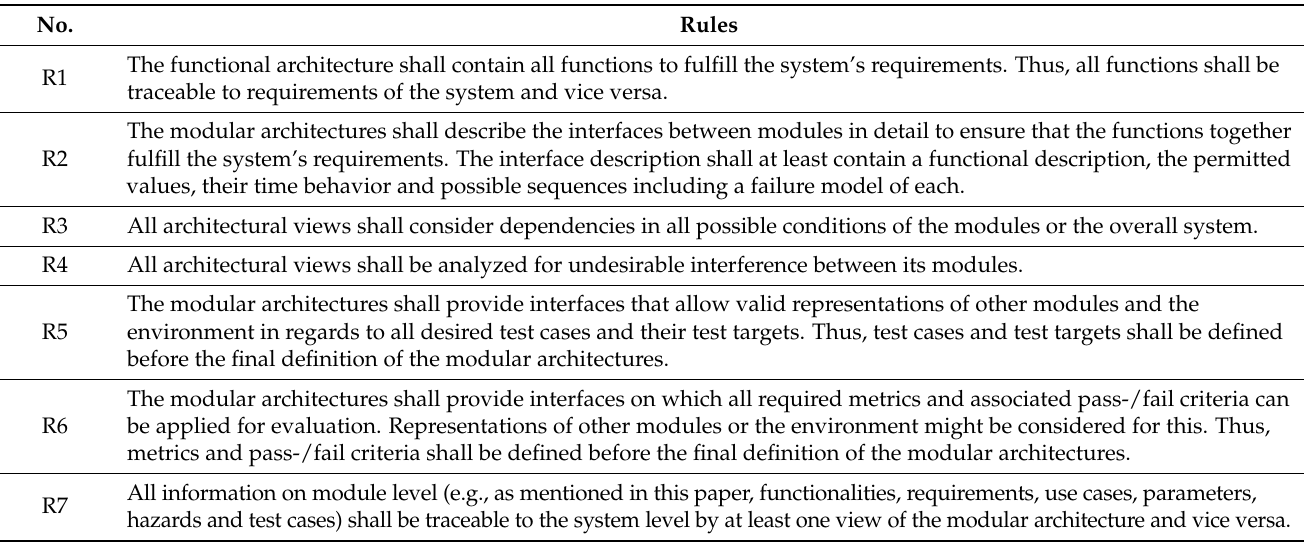
Table 2. List of rules (R) for the avoidance of errors due to